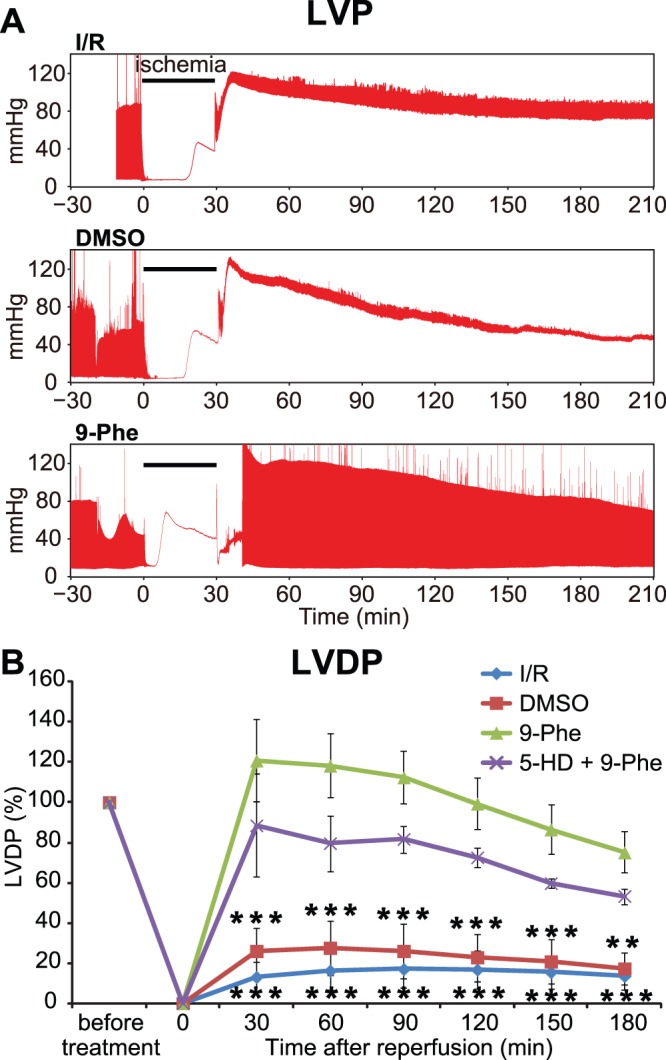
Measurement of cardiac contractile function.
A. Representative recordings of left ventricular pressure (LVP). In the I/R and DMSO groups, the cardiac contraction decreased severely after the reperfusion. In contrast, LVDP recovered dramatically at the end of the reperfusion period in the 9-Phe-treated group. B. Contractile function of the heart indicated by the left ventricular developed pressure (LVDP). Impaired contractile function caused by I/R injury was significantly recovered by treatment with 9-Phe. Simultaneous application of the KATP channel-blocker, 5-HD, did not significantly change the cardioprotective effect of 9-Phe. Asterisks indicate a significant difference compared with the 9-Phe group as determined using Bonferroni post hoc tests.***p<0.001,**p<0.01.